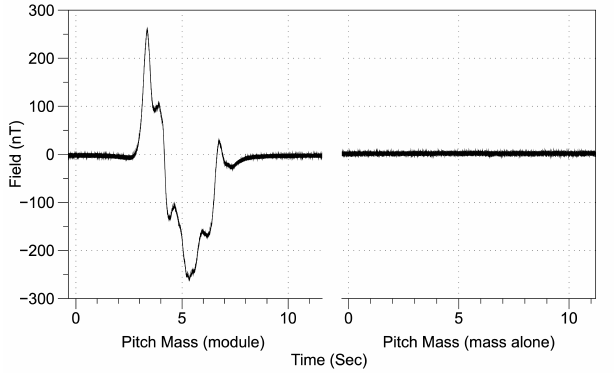
Figure 7. Magnetization test data for ROUGHIE components.